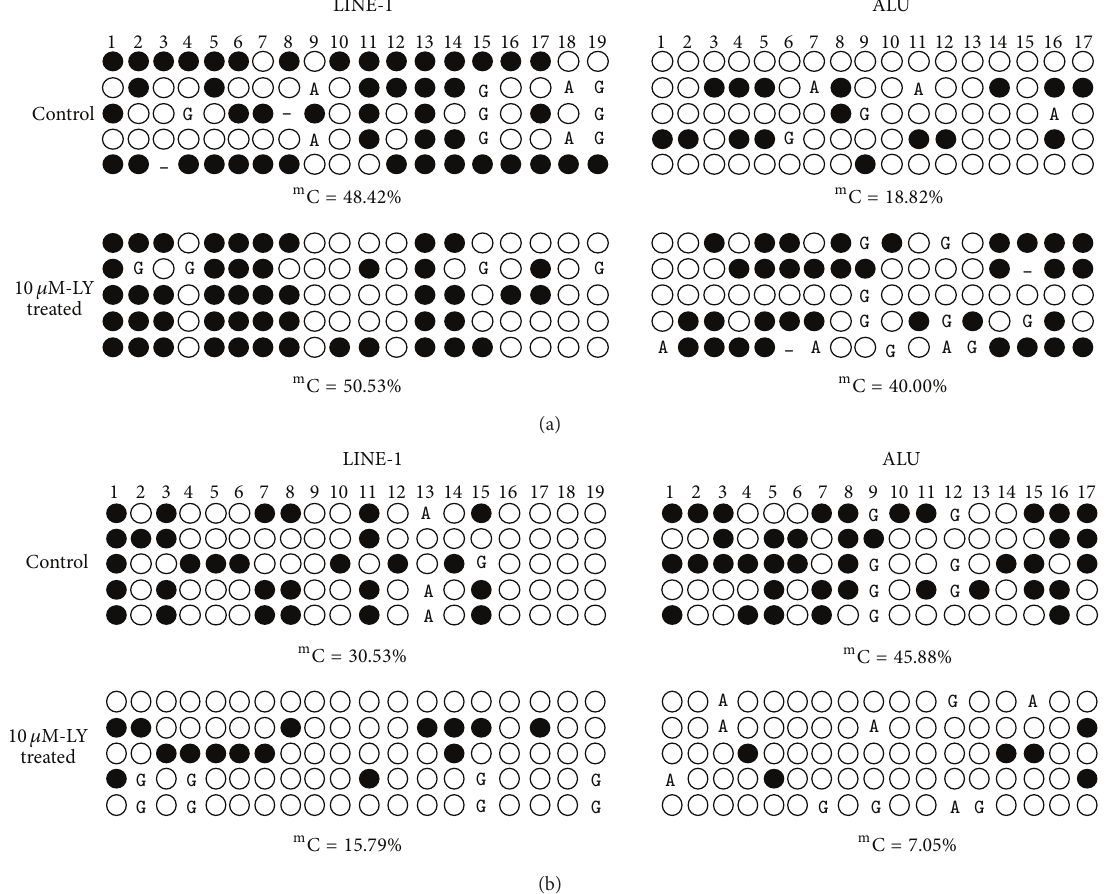
Figure 4: Effects of lycopene treatment on DNA methylation of LINE-1 and ALU elements in PCa cells. (a) Methylated cytosine in LINE-1 and ALU of lycopene treated PC-3 and control cells. (b) Methylated cytosine in LINE-1 and ALU of lycopene treated LNCaP and control cells. Each row of circles represents a single cloned allele (five clones per cell line). Filled and open circles indicate methylated and unmethylated cytosines,